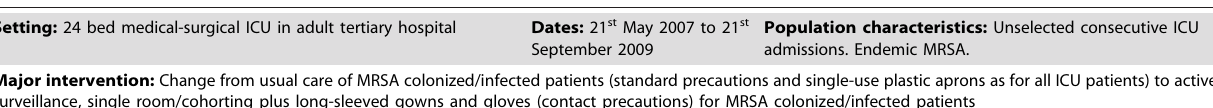
Table 1. Study characteristics and intervention.